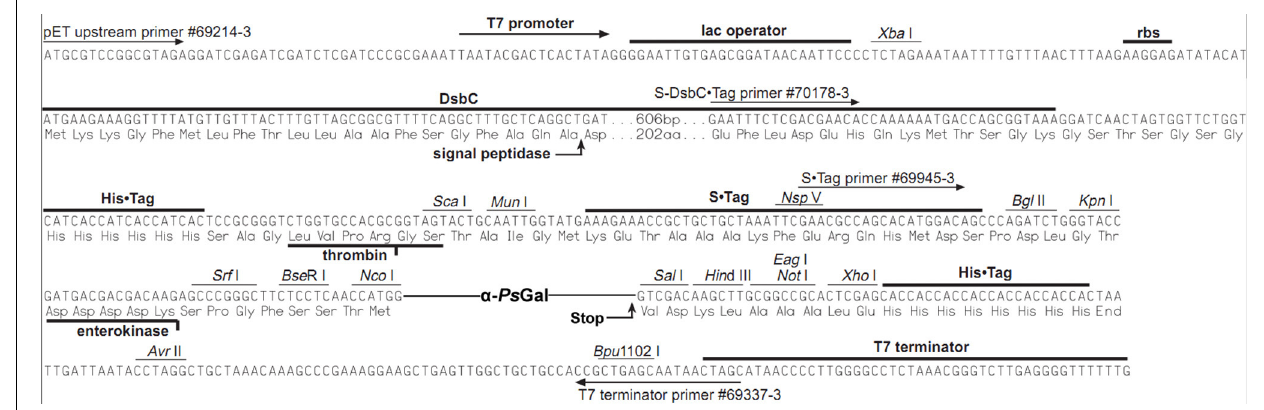
FIGURE 1 | The nucleotide and amino acid sequences of the α - Ps Gal expression region.